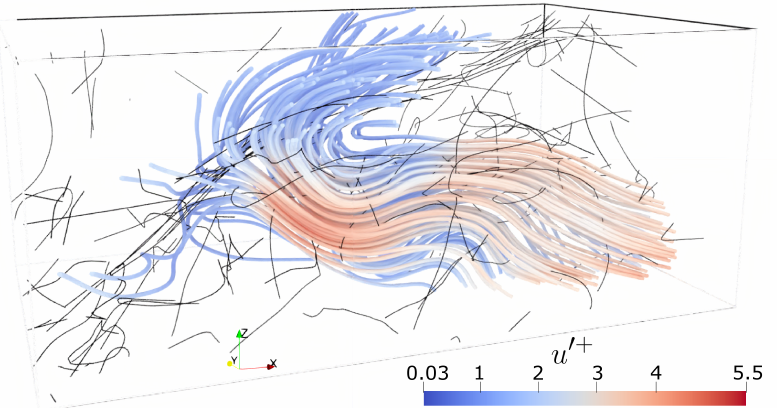
Figure 12. Visualization of the flow streamlines within a volume of size (cid:96) + x = 200; (cid:96) + y = 100; (cid:96) + z = 70 in wall units, centered at a distance of 50 wall units from the wall (for the reference case of St + n = 10 fibers and φ = 2.12 · 10 − 4 as volume fraction). The streamlines are colored according to the magnitude of the fluctuating fluid velocity. The fibers are also shown, rendered as thin black